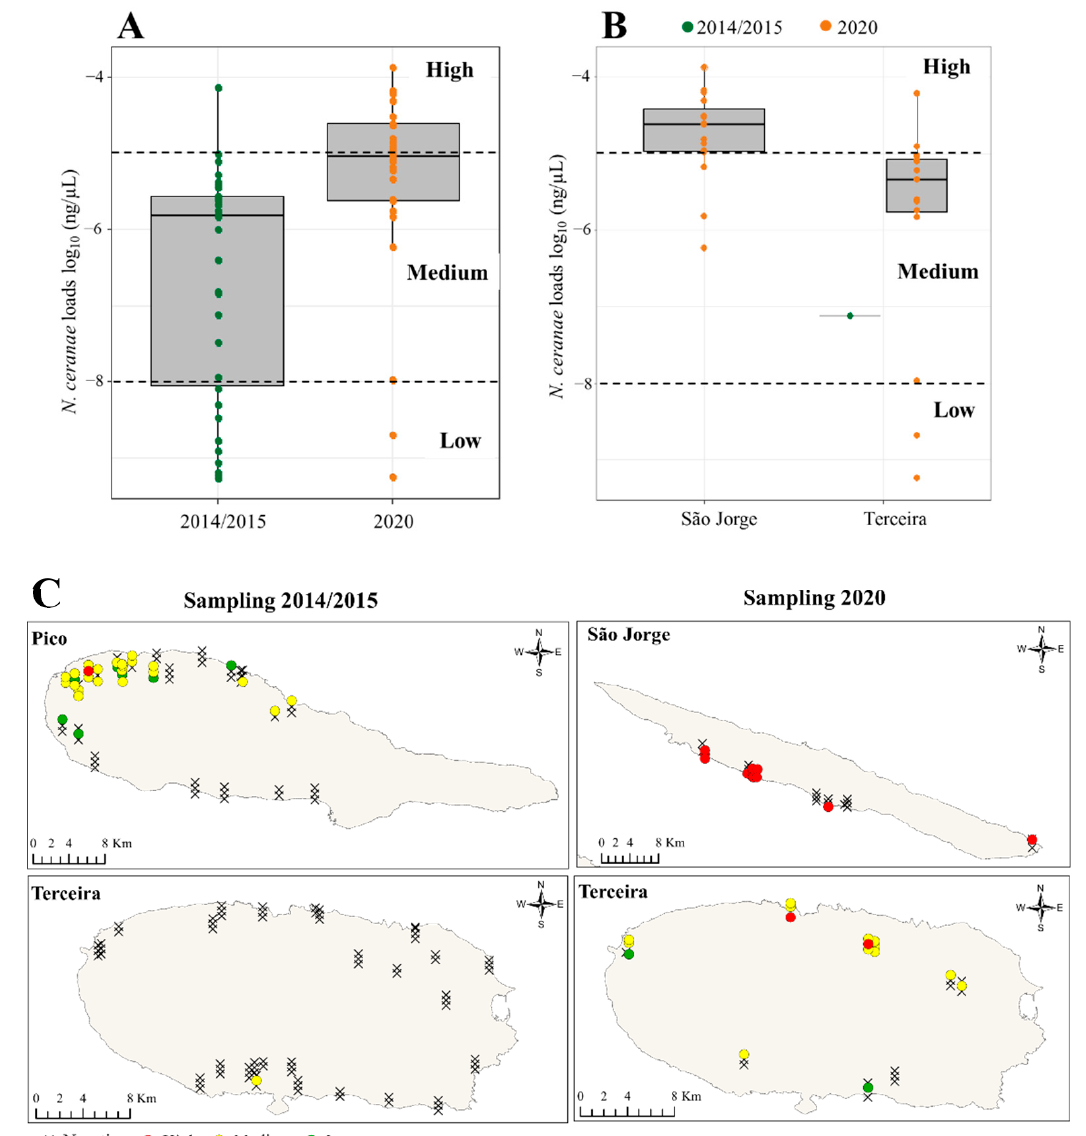
Figure 4. N. ceranae infection loads by sampling period and island. ( A ) Boxplot showing the distribution of the positive samples in 2014/2015 (green dots) and 2020 (orange dots); ( B ) Boxplot comparing the N. ceranae loads between the island sampled in 2014/2015 (green dots) and 2020 (orange dots); ( C ) Geographic distribution of the samples with infection levels classified as high (red dots); medium (yellow dots) and low infection (green dots). Negative samples are denoted by a cross mark.